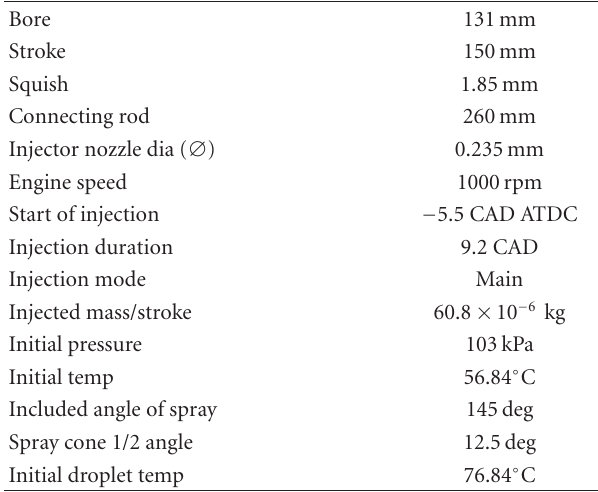
Table 3: The specifications and operating conditions of the Volvo D12C diesel